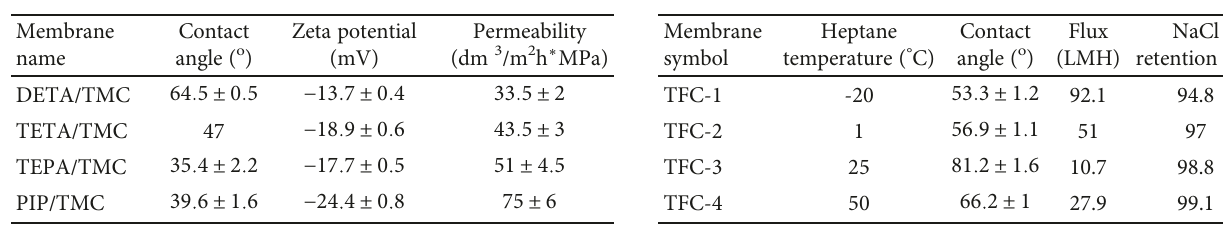
Table 1: Parameters of the membranes formed, depending on the monomer used [17].